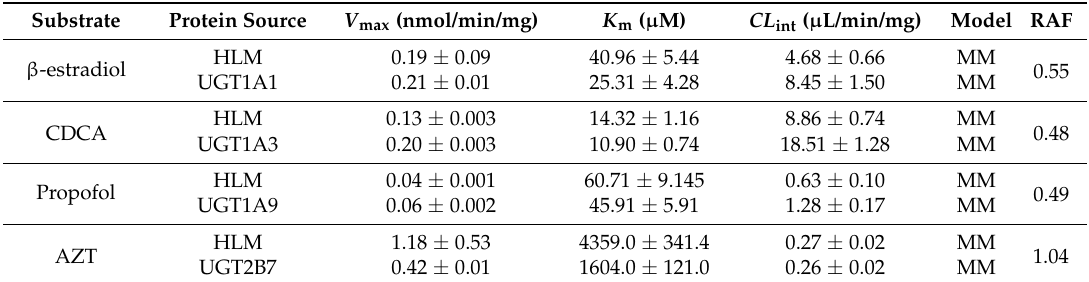
Table 2. Kinetic parameters and relative activity factor (RAF) values of substrate glucuronidation by pooled human liver microsomes (HLM) and individual expressed UGT enzyme (mean ± SD). All experiments were performed in triplicate.